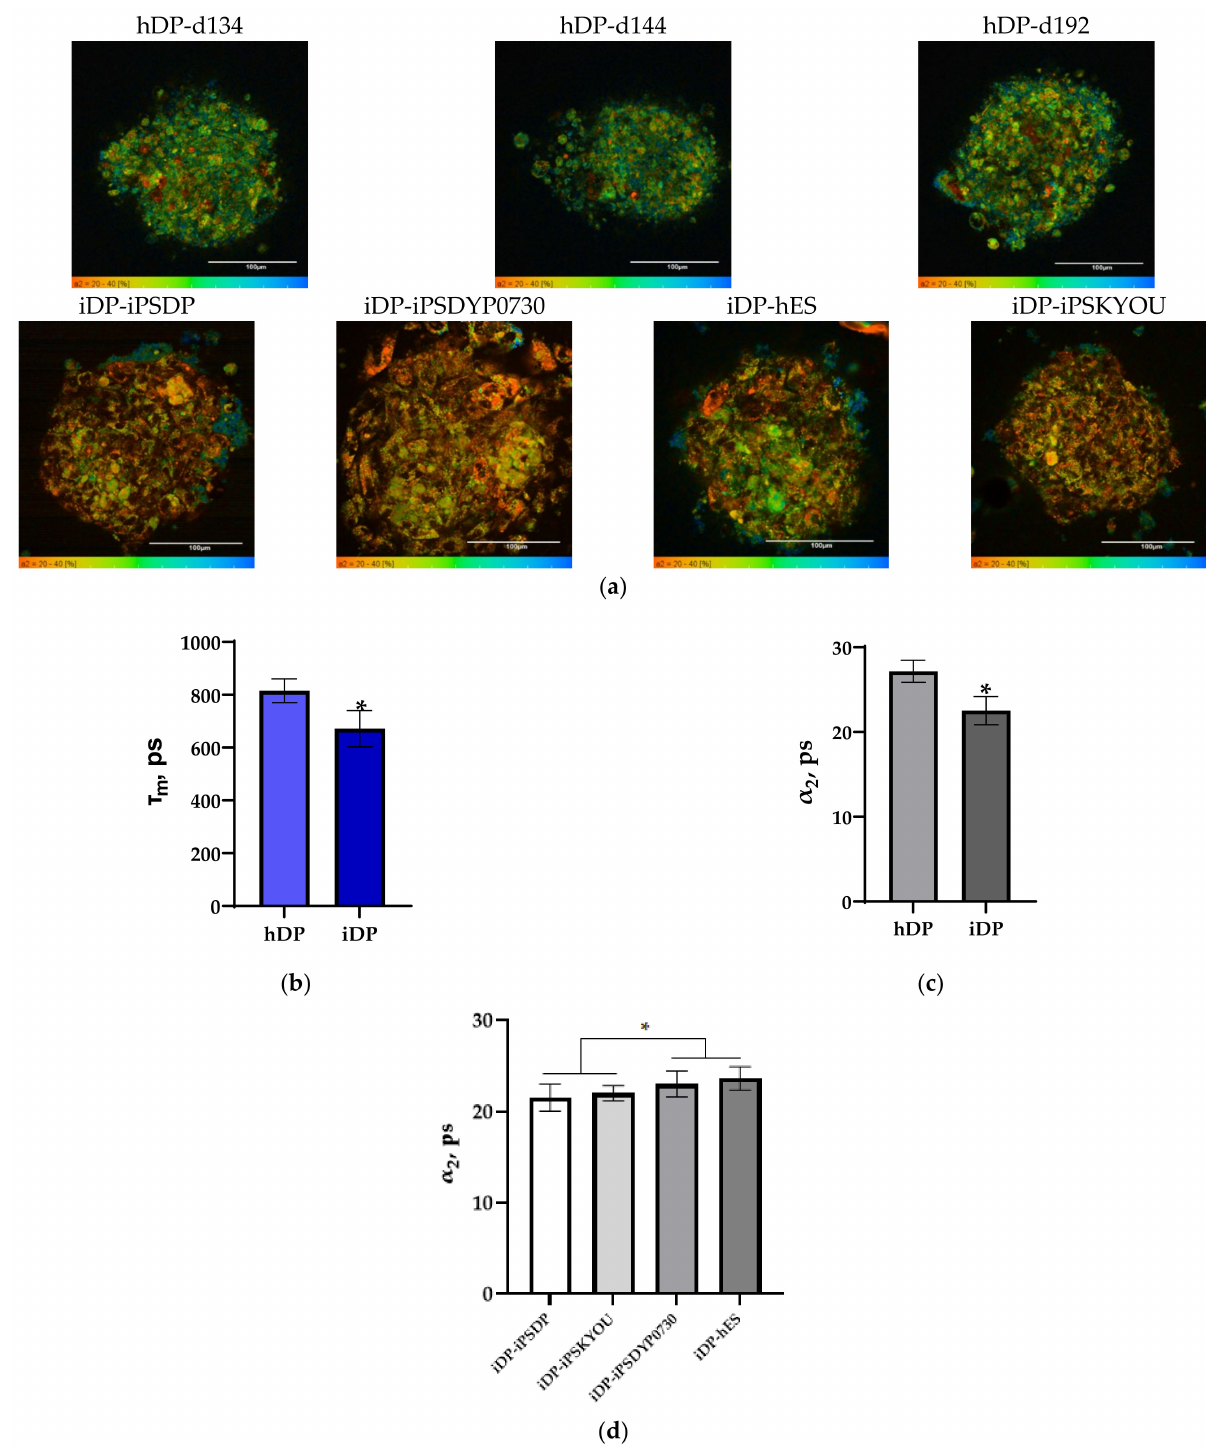
Figure 7. FLIM of NAD(P)H in the hDP spheroids, created from hDP-d134, hDP-d144, and hDP-d192 lines, and iDP spheroids, created from iDP-iPSDP, iDP-iPSDYP0730, iDP-hES, and iDP-iPSKYOU lines. ( a ) Pseudocolor-coded images of the contribution of the bound form of NAD(P)H in hDP and iDP spheroids (the scale bar for α 2 on images from 20% to 40%, the scale length in all pictures is 100 µ m). ( b ) Mean fluorescence lifetime of NAD(P)H in hDP and iDP spheroids (mean ± SD). ( c ) Fluorescence lifetime contributions of the bound form of NAD(P)H in hDP and iDP spheroids (mean ± SD). ( d ) Fluorescence lifetime contributions of the bound form of NAD(P)H in iDP spheroids created from different cell lines (mean ± SD). * p -value ≤